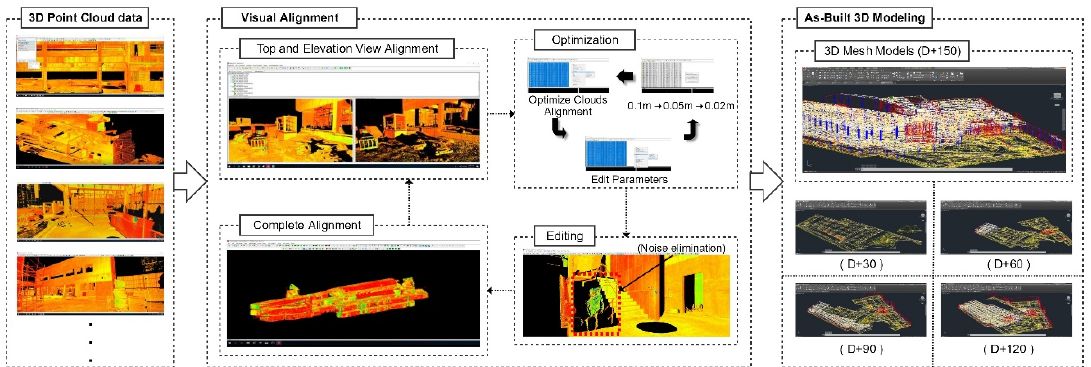
Figure 7. 3D mesh model at each time of the as-built data collection.